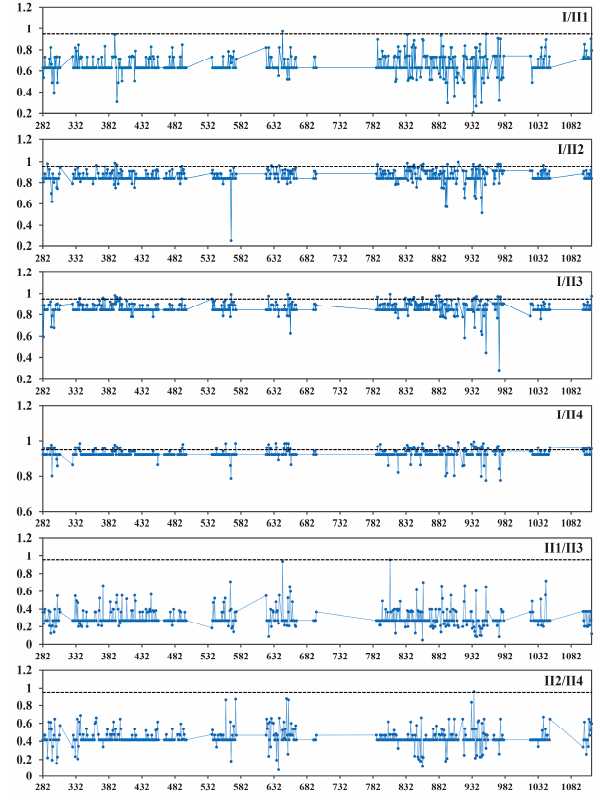
Figure 8. Type I functional divergence among the TPS family members of Rosacaea. Posterior probability analysis of specific amino acid sites was used for identifying critical amino acid residues. The cutoff = 0.95 is shown by the dotted line.